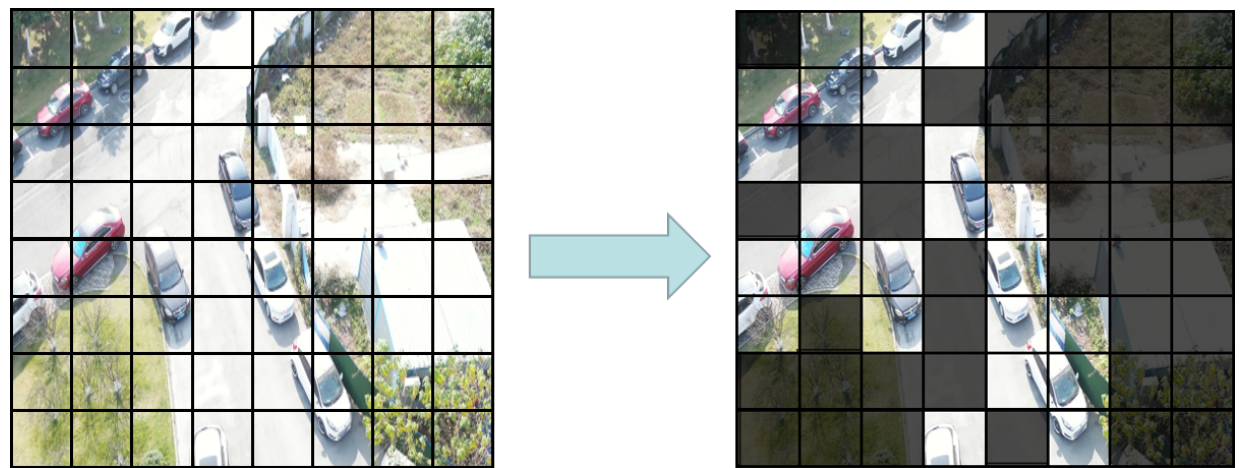
Figure 4. A visual schematic diagram of